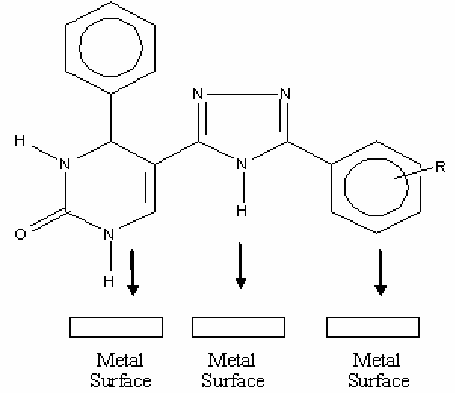
Table 5. Impedance parameters for mild steel in 1 M H concentrations of the inhibitors Name of